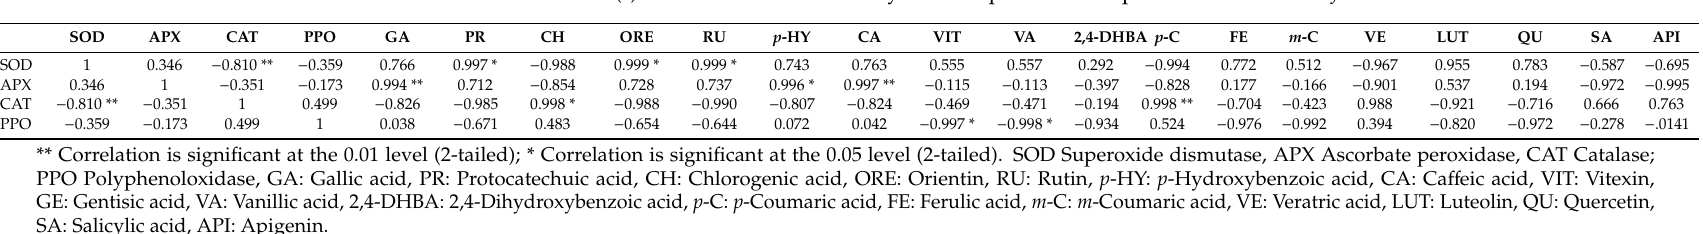
Table 7. Pearson correlation coe ffi cients (r) between antioxidant enzymes and phenolic compounds of M. sacchariflorus